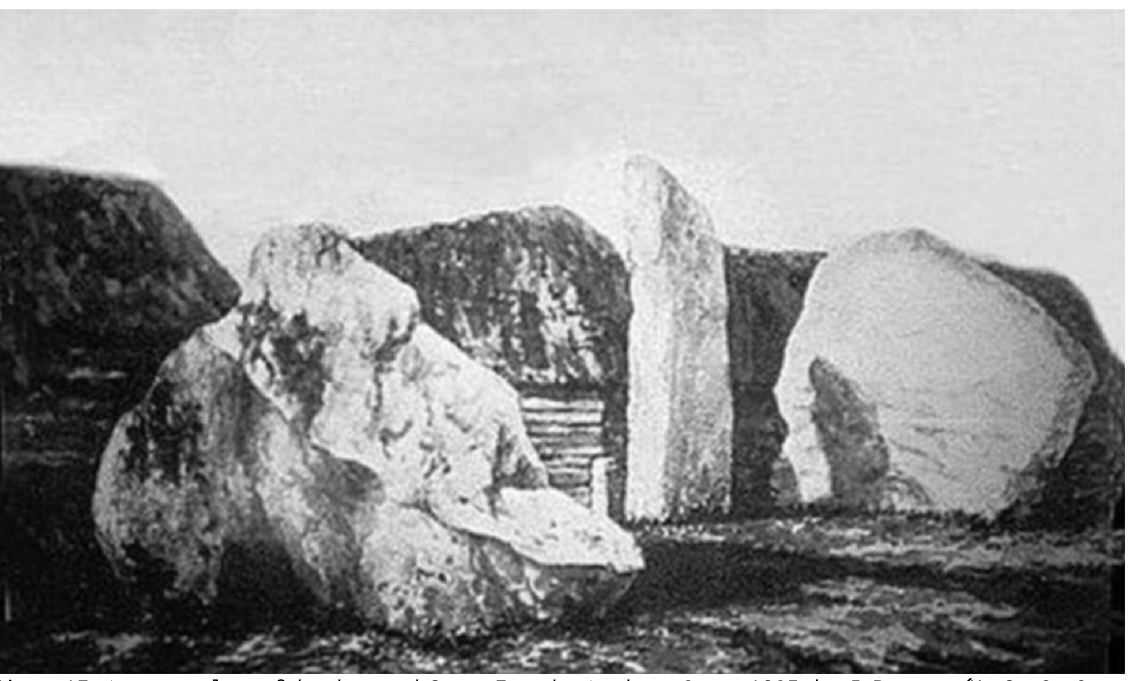
Figure 17. A watercolour of the damaged Stone F at the Avebury Cove, 1825, by J. Browne (H. St. G. Gray 1935: